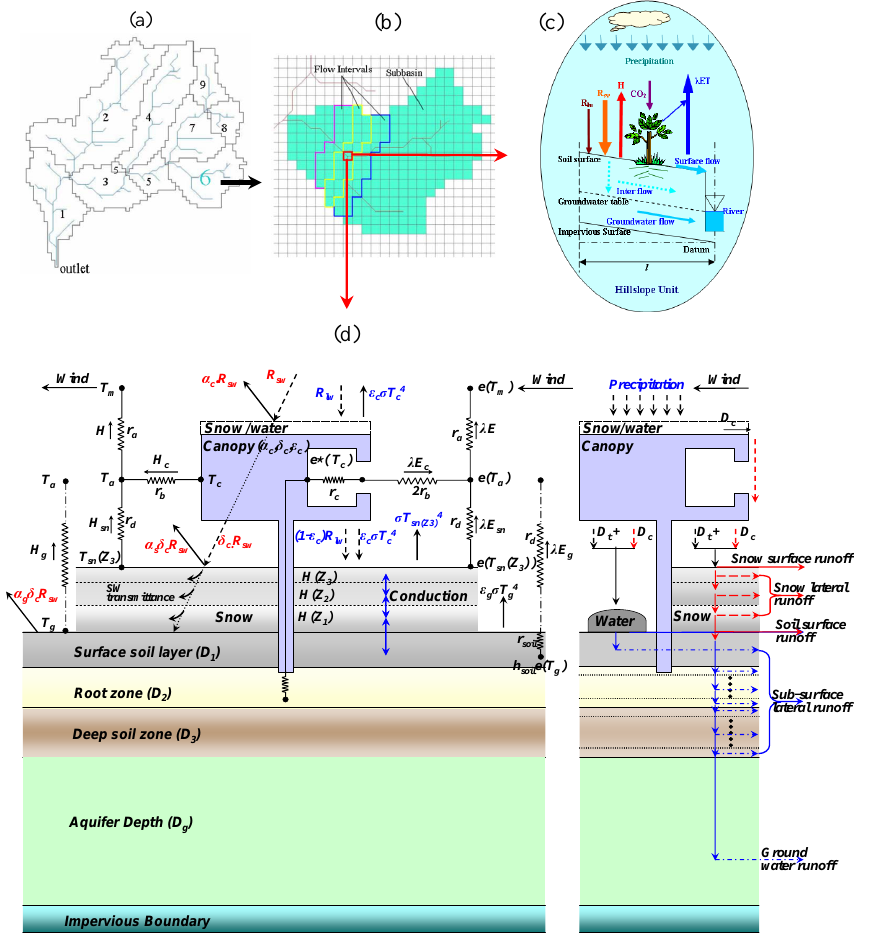
Fig. 1. Overall structure of WEB-DHM-S model. (a) Division from basin to sub-basin; (b) subdivision from sub-basin to flow intervals comprising several model grids; (c) description of water transfer from atmosphere to river ( a , b and c ; after Wang et al., 2009a); (d) detailed description of vertical 3-layer energy balance snow model, for which T is temperature, e(T ) is vapour pressure at T , R sw and R lw are downward shortwave and longwave radiation, H and λE are sensible and latent heats, and ε , δ and α are emissivity, transmittance and reflectance, respectively. Subscript c refers to canopy, g to soil surface, sn to snow surface, and m to the reference height. Calculation of energy fluxes and aerodynamic resistances ( r a , r b , r c , r d and r soil ) follows SiB2 (Sellers et al., 1996). D c and D t are canopy drainage and direct throughfall. H(Z j ) is enthalpy of the snow layer ( Z j ) (after Shrestha et al.,